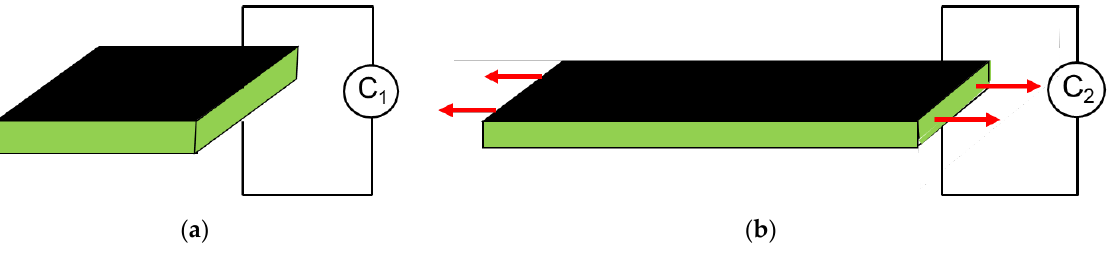
Figure 1. Scheme of a dielectric elastomer strain sensor ( a ) that is stretched in one dimension ( b ), where the capacitance is enhanced.